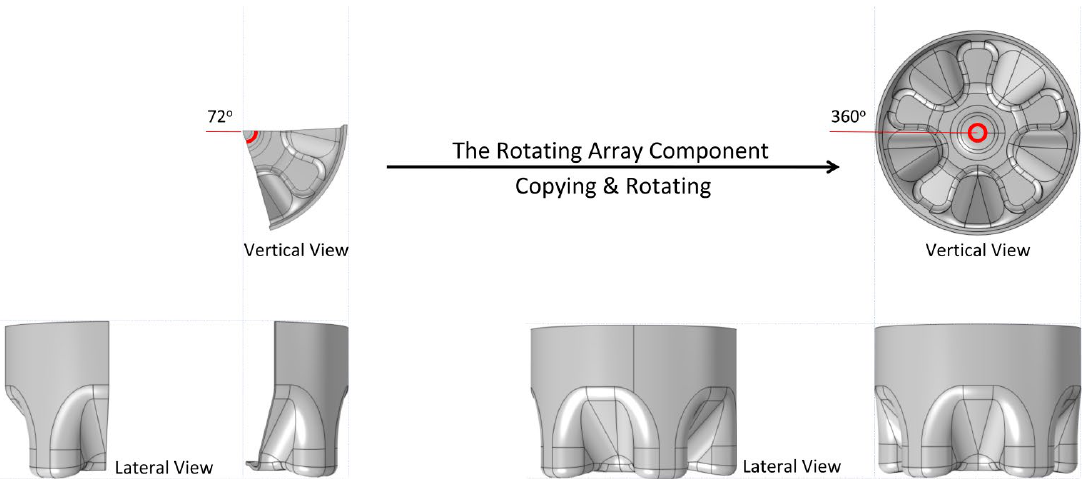
Figure 2. Symmetry hypothesis for fast modeling and calculation.